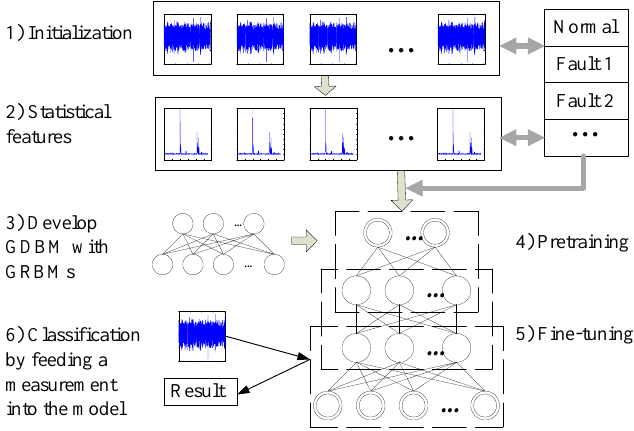
Figure 3. Flowchart of the deep statistical feature learning technique for the fault diagnosis of the rotating machinery.